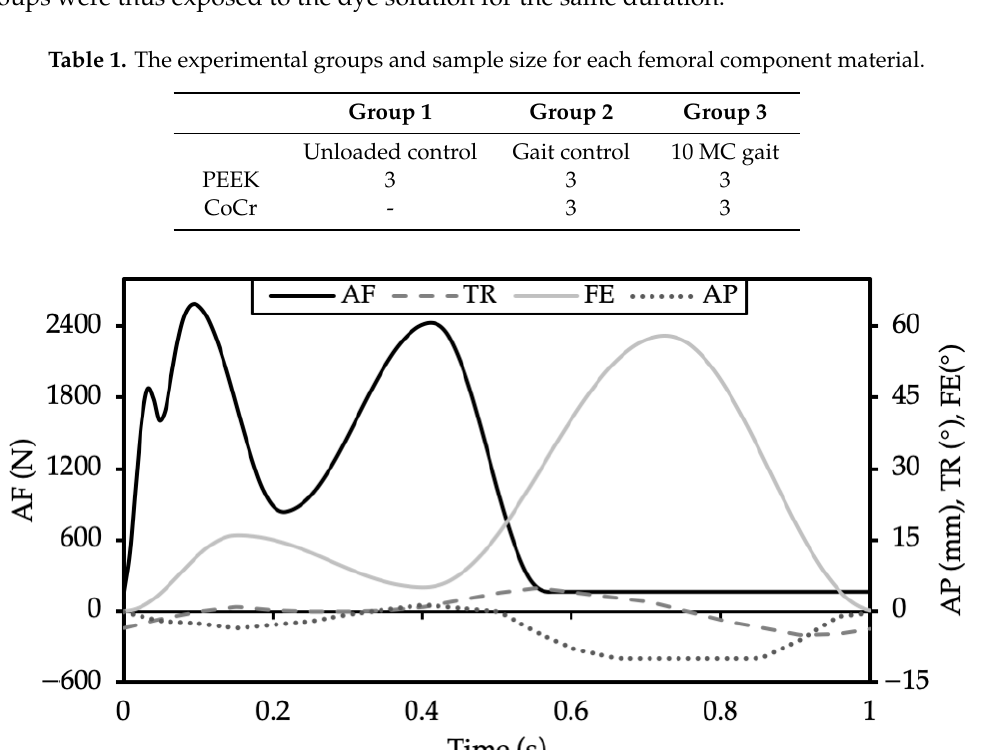
Figure 2. Input profiles for cyclic loading on the knee simulator. The parameters are axial force (AF), tibial rotation (TR), flexion-extension angle (FE) and anterior-posterior displacement (AP)